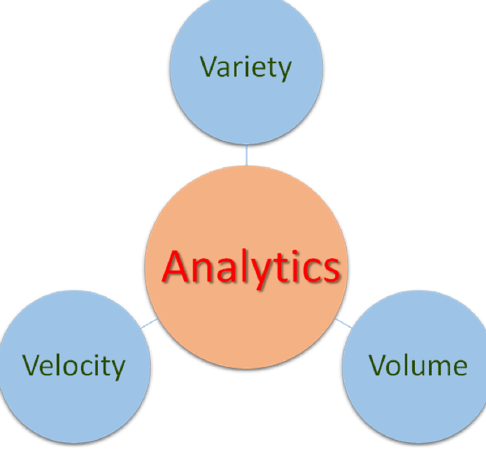
Fig. 5. Dimensions of Big